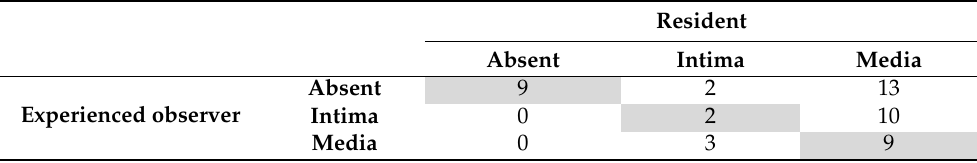
Table 2. Inter-observer agreement for radiography.